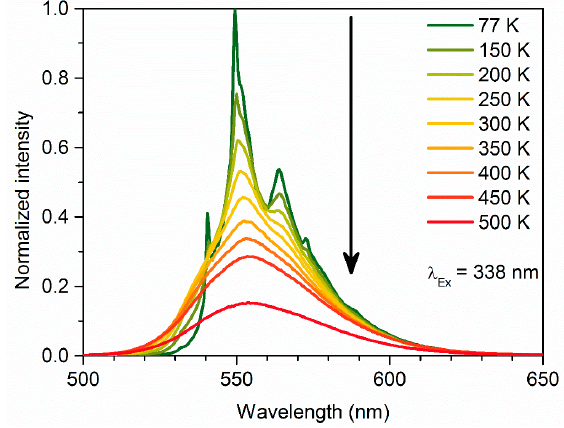
Figure 11. Emission spectra of Gd 3 Li 3 (Te 0.99 U 0.01 ) 2 O 12 at various temperatures. Excitation wavelength was set to 338 nm.